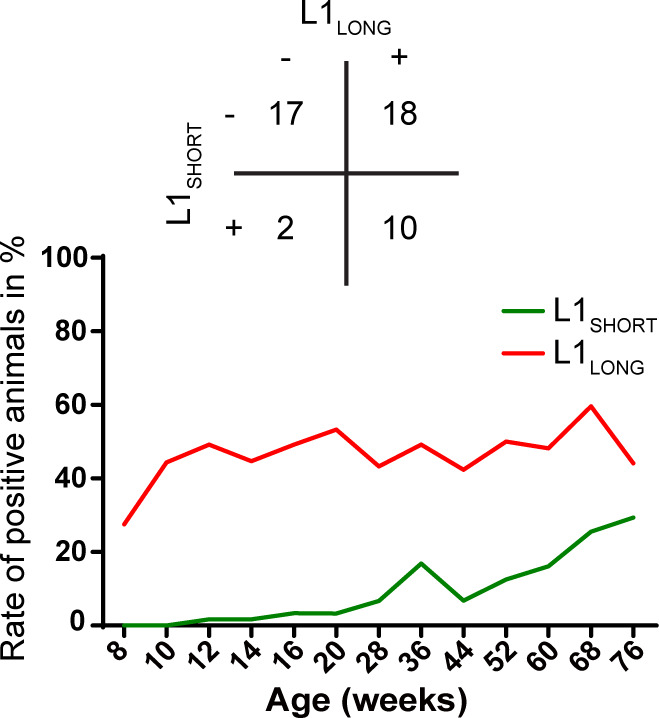
Rate of L1LONG and L1SHORT positive animals.Rate of L1LONG and L1SHORT positive animals at different time points of the follow-up study. The 2 × 2 contingency table used for the two-tailed McNemar’s test shows the 68 week time point, which was used for the main comparison, since here, most animals were still alive.